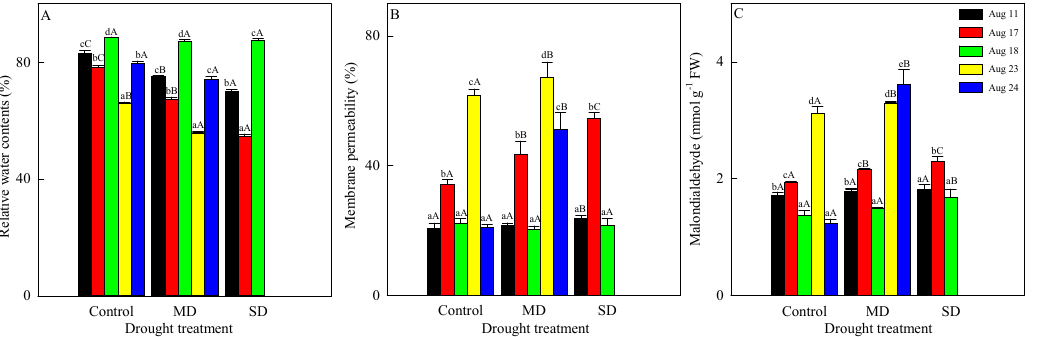
Figure 2. Changes in ( A ) Relative water contents (RWC), ( B ) membrane permeability, and ( C ) the malondialdehyde content of A. halodendron under drought and in the rehydration phase. Values represent mean ± SE. Bars labelled with different lowercase letters represent significant differences among days for a given treatment. Bars labelled with different capital letters differ significantly among drought treatments on a given day. 11, 17 and 23 August 2018 correspond to drought, 18 and 24 August 2018 correspond to rehydration.